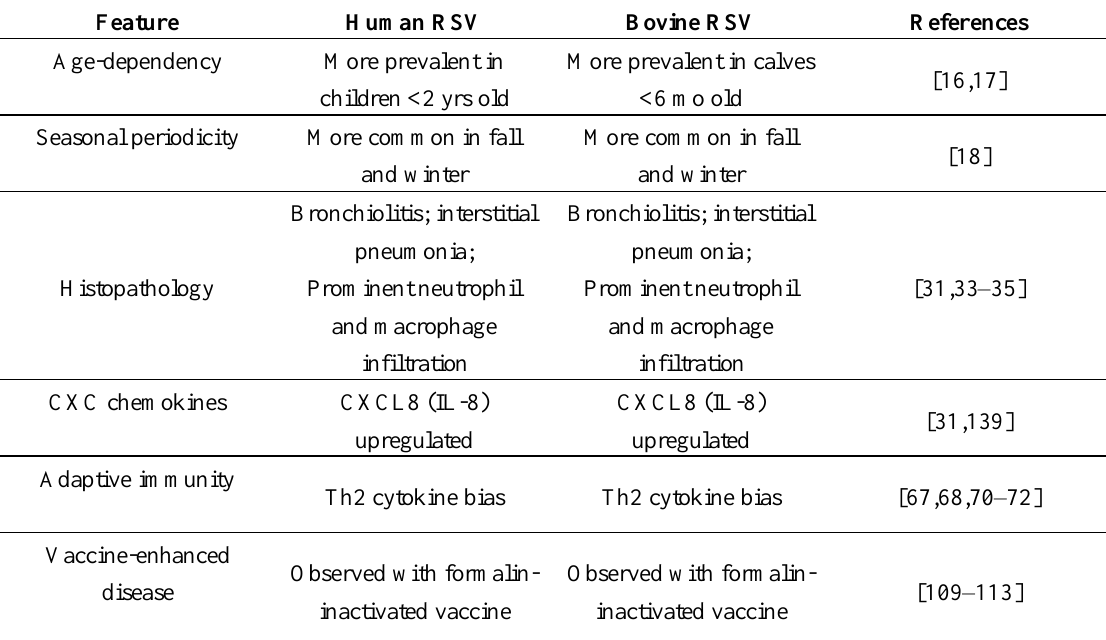
Table 1. Features common to hRSV in infants and bRSV in